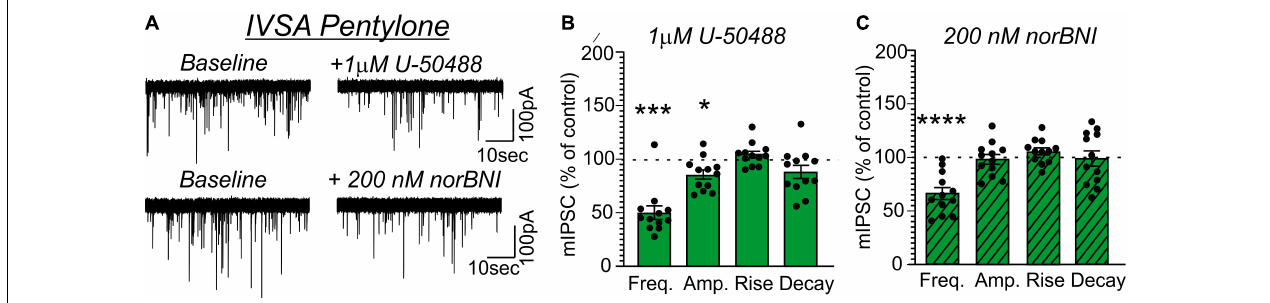
FIGURE 8 | (A) Representative mIPSCs from CeA neurons during control and during superfusion with the KOR-agonist U-50488 (1 µ M, upper panel) or the KOR-antagonist norBNI (200 nM, lower panel) are shown. Bars represent means ± S.E.M of the normalized effects either (B) U-50488 or (C) norBNI at the indicated concentration on mIPSC characteristics. Statistically significant differences to baseline control were calculated using a one-sample t -test. (*) = P < 0.05, (***) = P < 0.001, (****) = P < 0.0001.